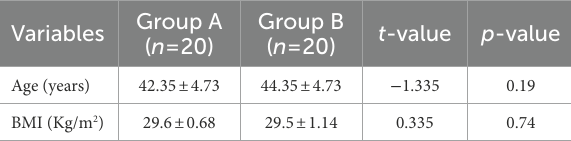
TABLE 1 General characteristics of both groups.